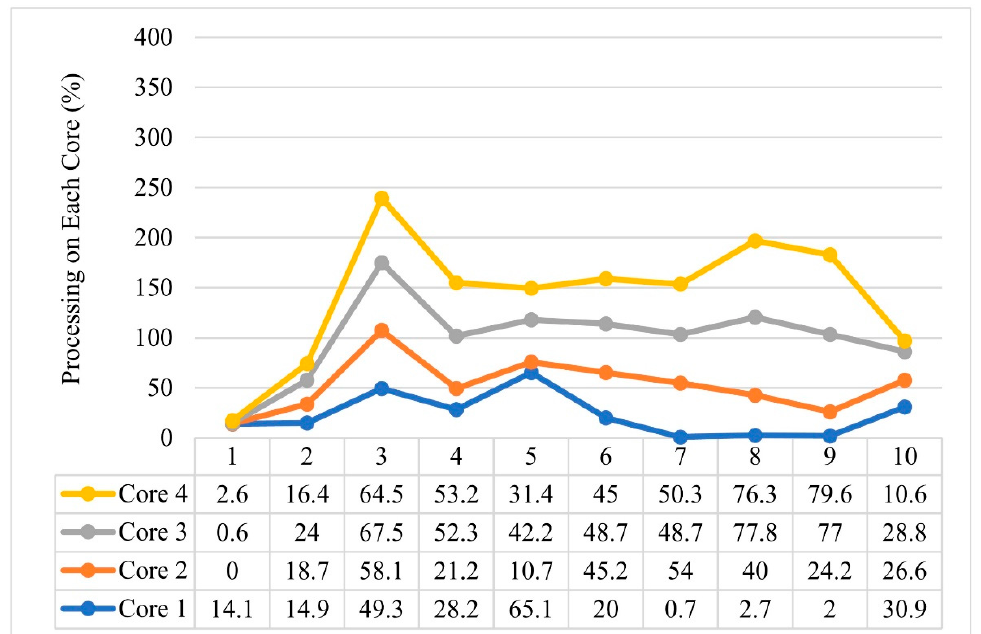
Figure 8. The consumption of each core (400% for four cores) of CPU for the parallel mode with J48 when using CST-GR selected features.